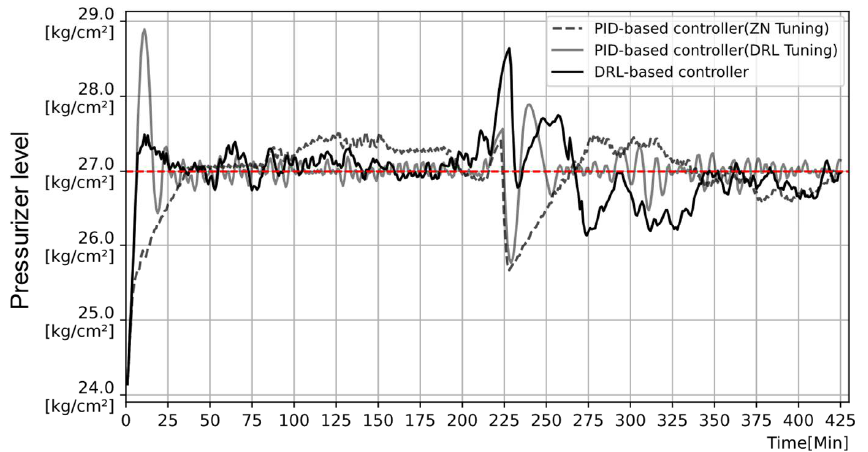
Figure 20. Comparisons of controllers for the pressurizer pressure.